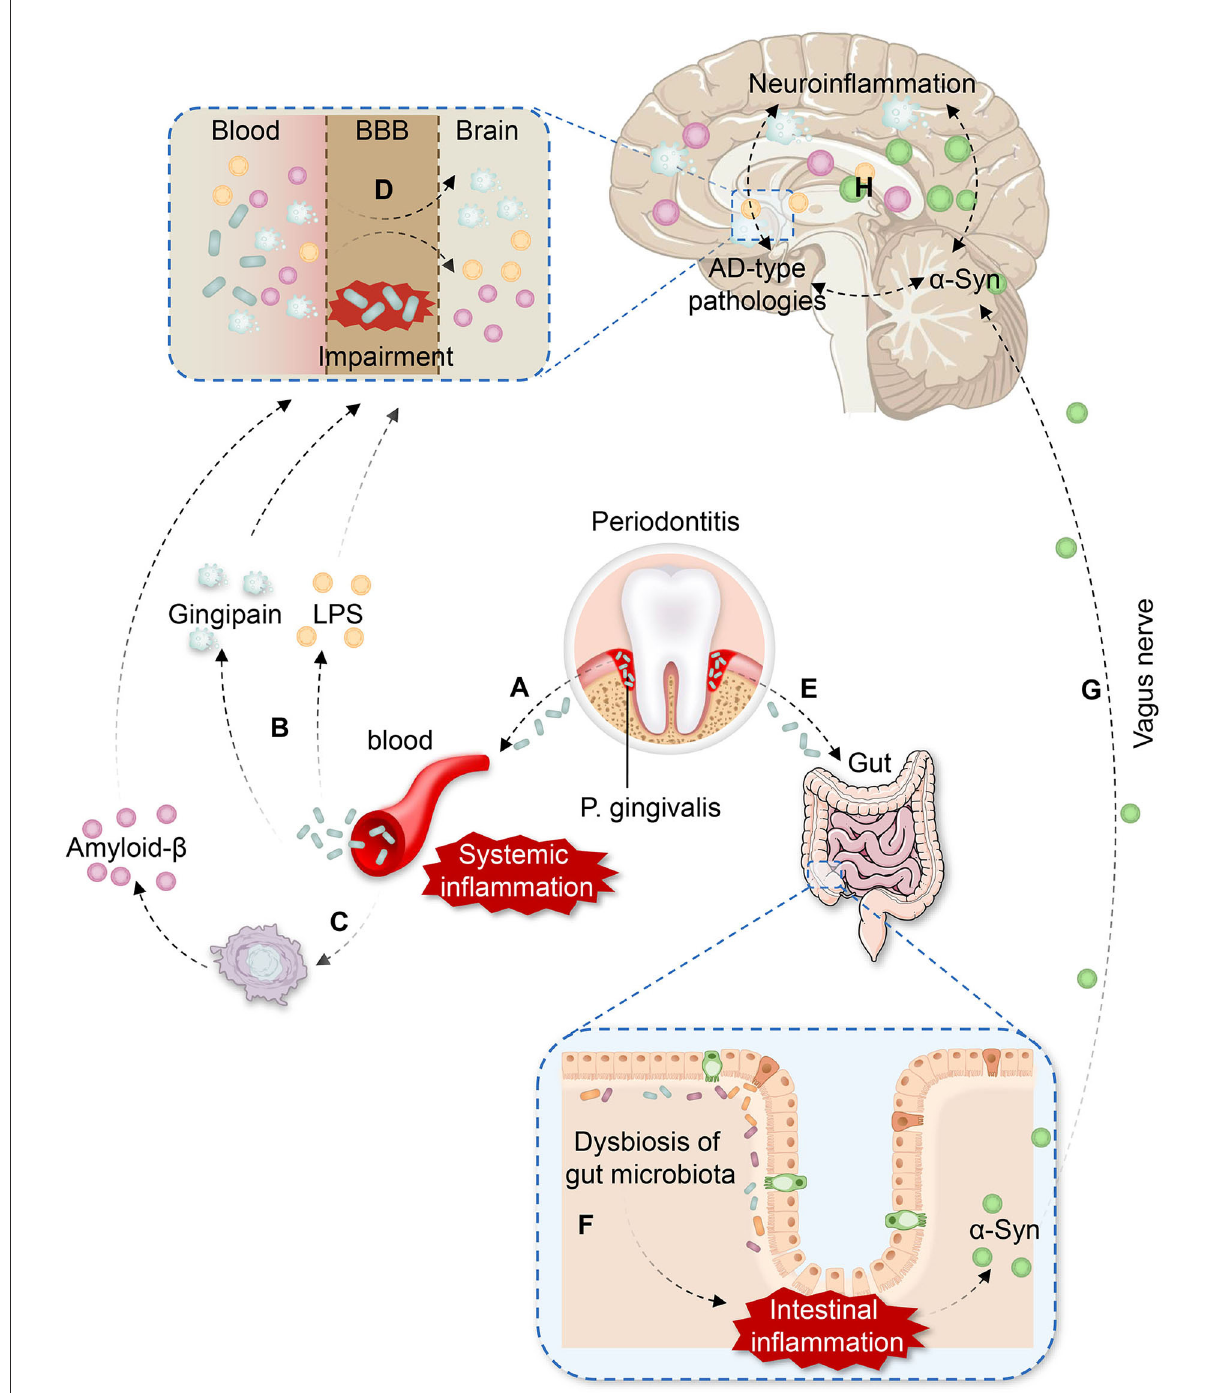
FIGURE1 The potential pathways of P. gingivalis involvement in Parkinson’s disease with cognitive impairment (PD-CI). (A) P. gingivalis enters the vasculature from the periodontal pocket, leading to bacteremia and systemic inflammation. (B) Gingipain and lipopolysaccharide (LPS) produced by P. gingivalis are present in the blood. (C) P. gingivalis infection induces the production of peripheral amyloid- β (A β ) in inflammatory macrophages. (D) P. gingivalis impairs the function of the blood-brain barrier (BBB) by facilitating LPS, gingipain, and peripheral A β entry to the brain more easily, which causes neuroinflammation and Alzheimer’s disease (AD)-type pathologies. (E) P. gingivalis is swallowed and enters the intestine. (F) P. gingivalis induces dysbiosis of the gut microbiota and intestinal inflammation, contributing to the accumulation of aberrant α -Synuclein ( α -Syn) in the gut. (G) Aberrant α -Syn propagates from the gut to the brain via the vagus nerve. (H) Neuroinflammation, AD-type pathologies, and α -Syn promote each other effect in the brain, leading to a vicious cycle and resulting in